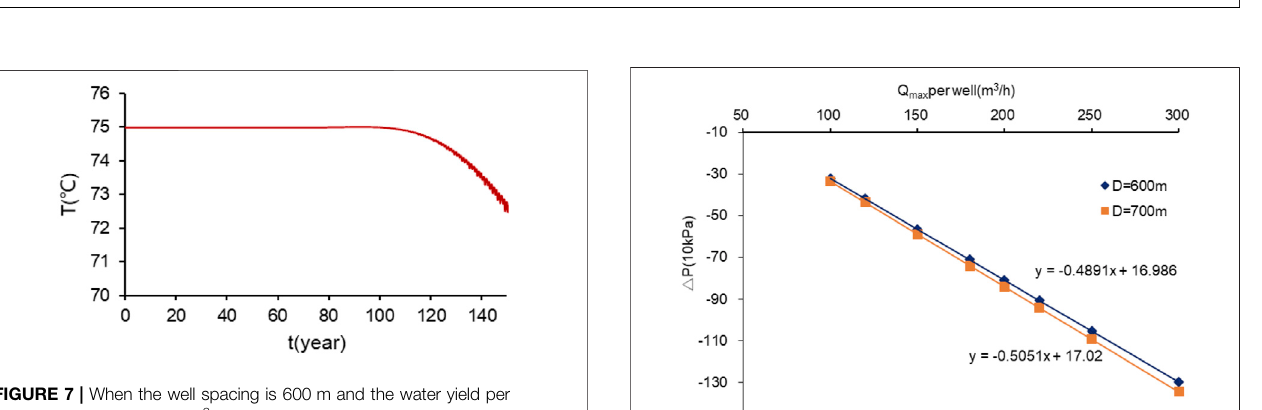
FIGURE 6 | When the well spacing is 600 m and the water yield per production well is 223.64 m 3 /h, the temperature distribution displays in the geothermal fi eld in the year 100.